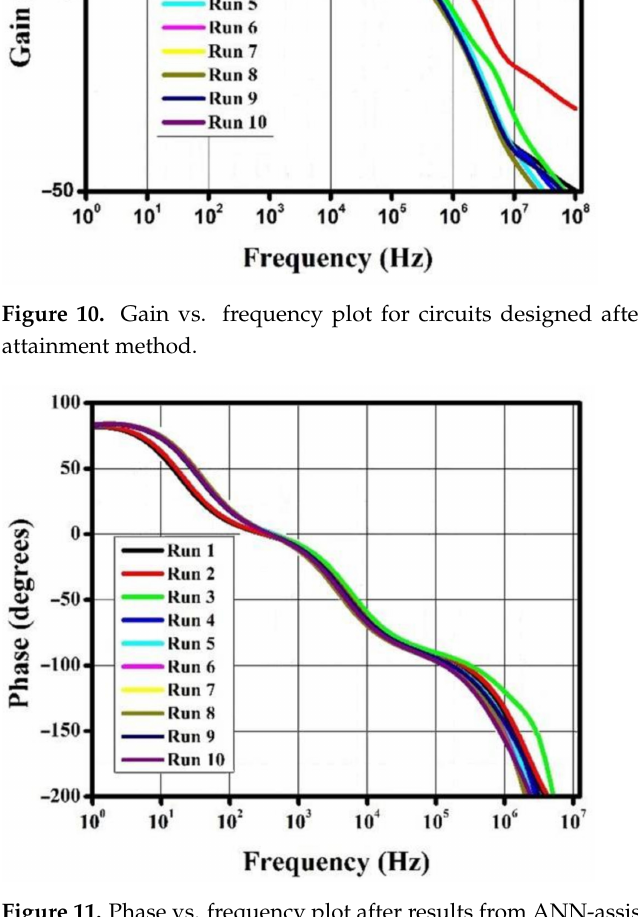
Figure 11. Phase vs. frequency plot after results from ANN-assisted goal attainment